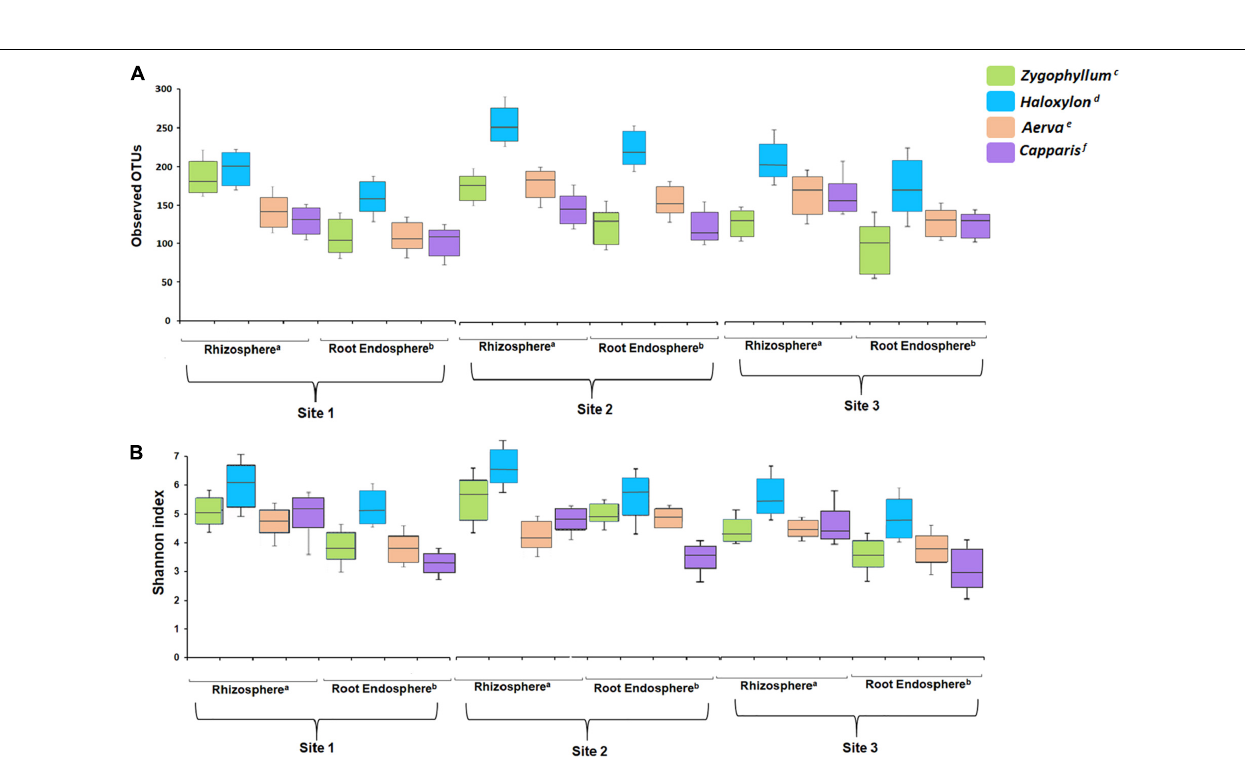
Frontiers in Microbiology |